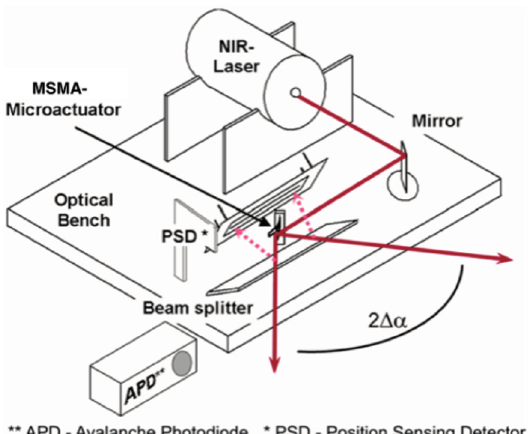
Figure 15. Schematic of the microscanner system. The optical beam path is indicated for the two extreme microactuator positions. Reprinted with permission from [65], copyright 2006 IOS Press.